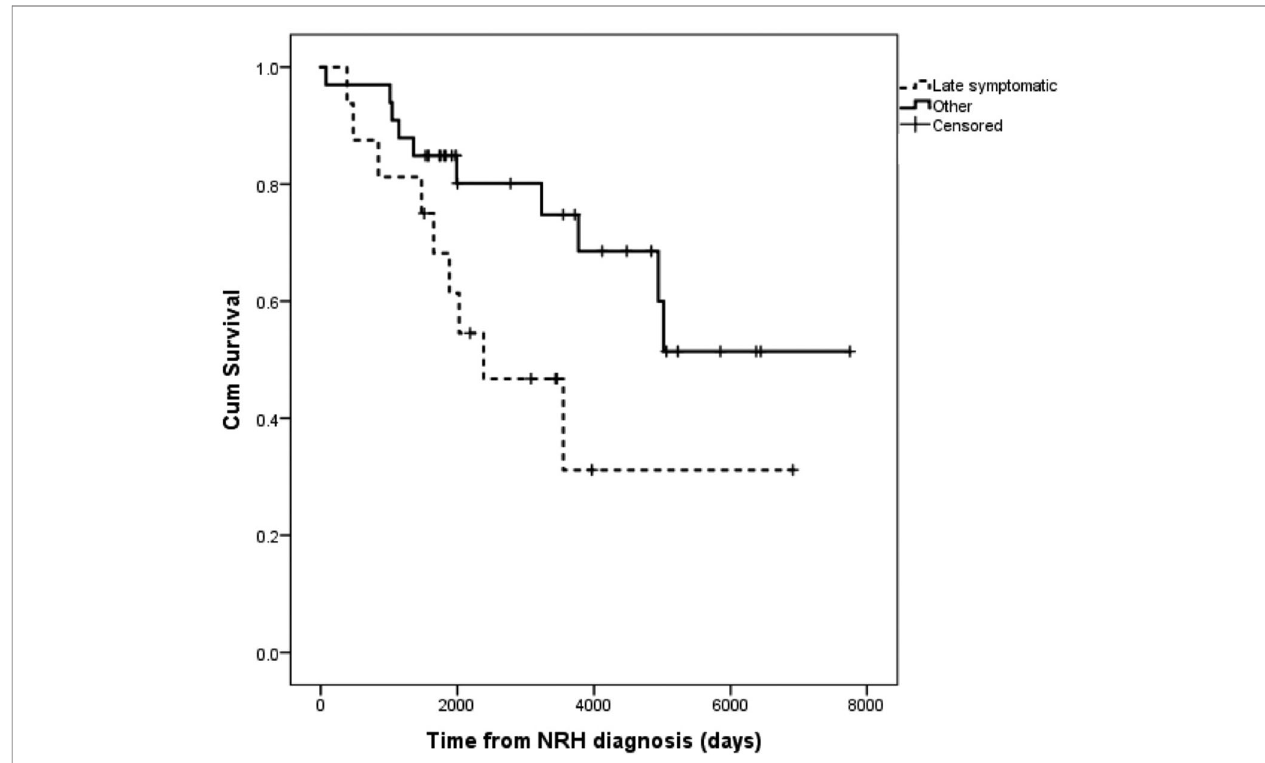
FIGURE 2 | Kaplan-Meier survival of patients with late-symptomatic presentations of NRH versus all other patients with